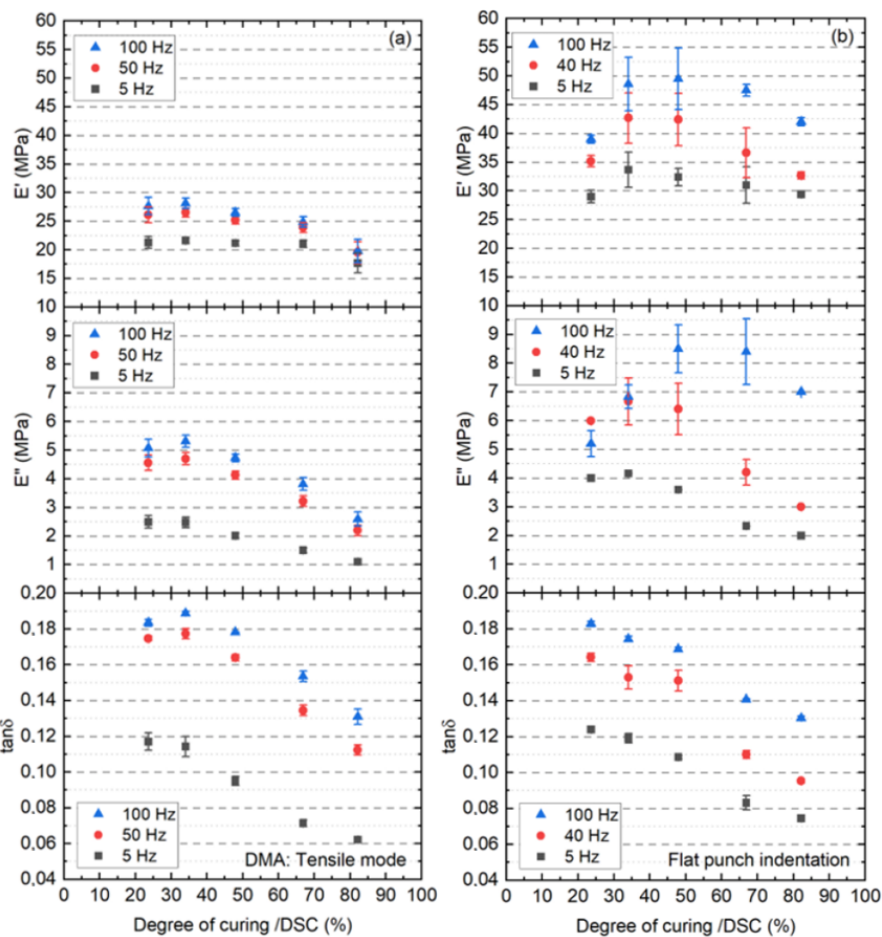
Figure 15. Storage modulus (top), loss modulus (mid) and damping factor (bottom) calculated from DMA tensile mode of the EVA bulk ( a ) and nanoindentation dynamic mode of the EVA surface ( b ) as a function of 5 different